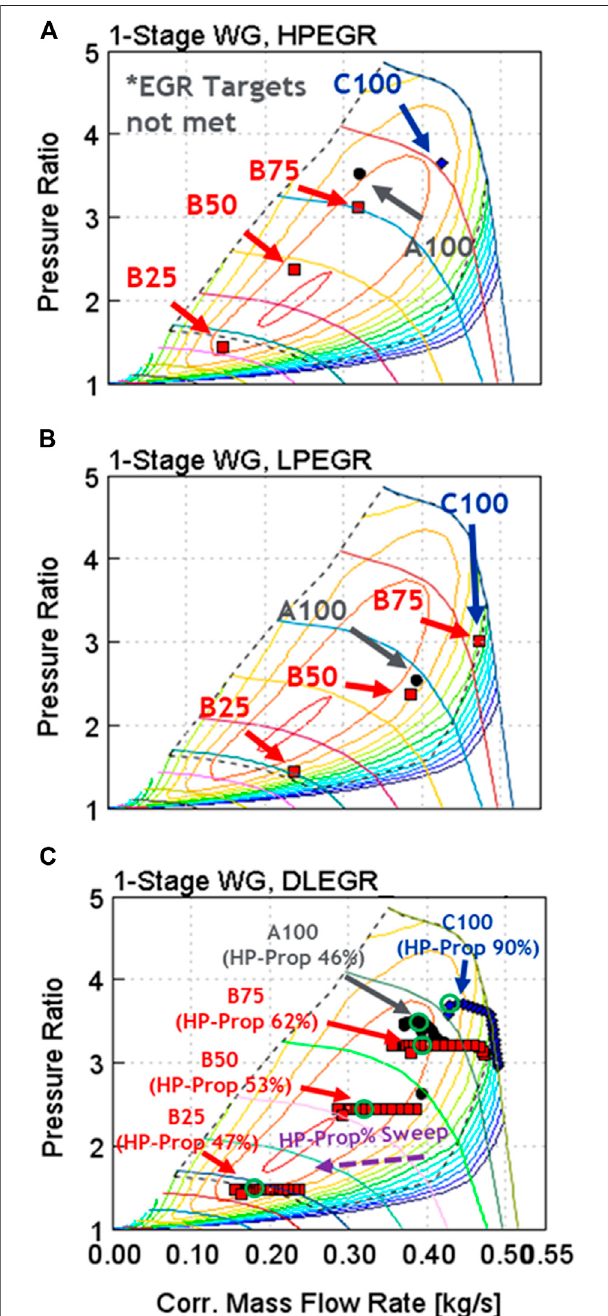
FIGURE 8 | Turbocharger-Engine matching for the advanced 1-Stage WG Turbocharger using (A) HPEGR, (B) LPEGR and (C) DLEGR con fi